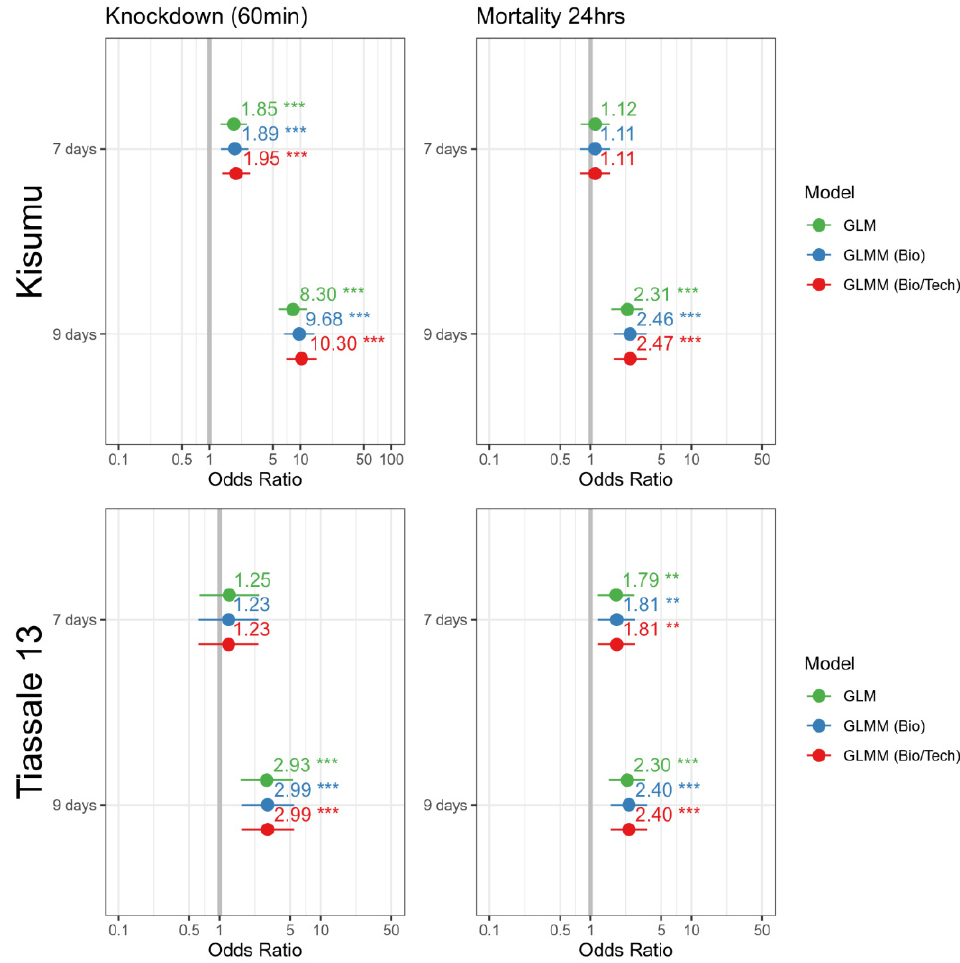
Figure A2. Odds ratio plot for age. The dataset was screened using a binomial GLM, binomial GLMM with random effect for biological replicate, binomial GLMM with a random effect for biological replicate and a nested random effect for technical replicate using the glmmTMB package in R. For this analysis, the variable was the age as a factor with 5 days used as a reference. Age groups are represented by the oldest possible age within that group. P-value significance indicated by ‘**’ if ≤ 0.01 and ‘***’ if ≤ 0.001.